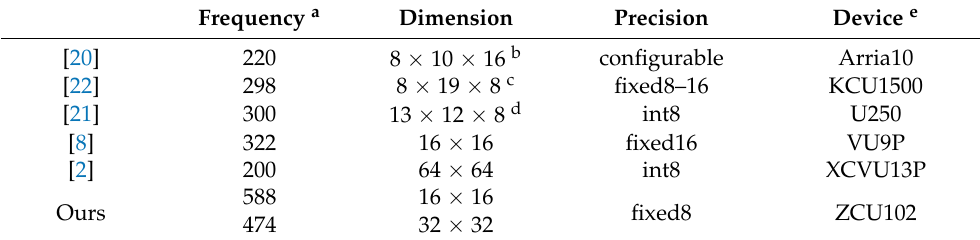
Table 2. Comparison of systolic arrays’ performances to related works. Frequency a Dimension Precision Device e [20] 220 8 × 10 × 16 b configurable Arria10 [22] 298 8 × 19 × 8 c fixed8–16 KCU1500 [21] 300 13 × 12 × 8 d int8 U250 [8] 322 16 × 16 fixed16 VU9P [2] 200 64 × 64 int8 XCVU13P 588 16 × 16 Ours fixed8 ZCU102 474 32 × 32